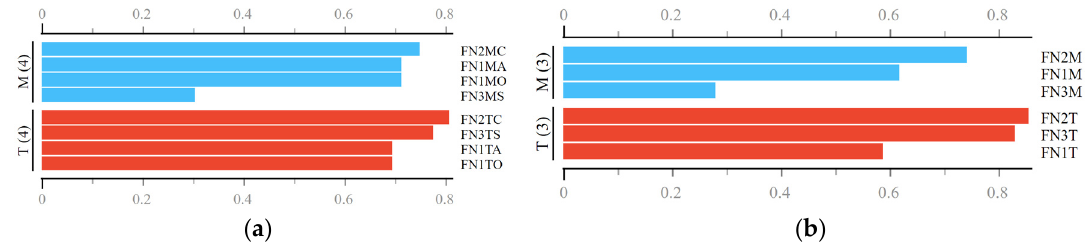
Figure 6. Silhouette plots showing the consistency of the clusters. Legend: ( a ) silhouette plots of the clusters shown in Figure 5, ( b ) silhouette plots of the clusters shown in Figure 7.